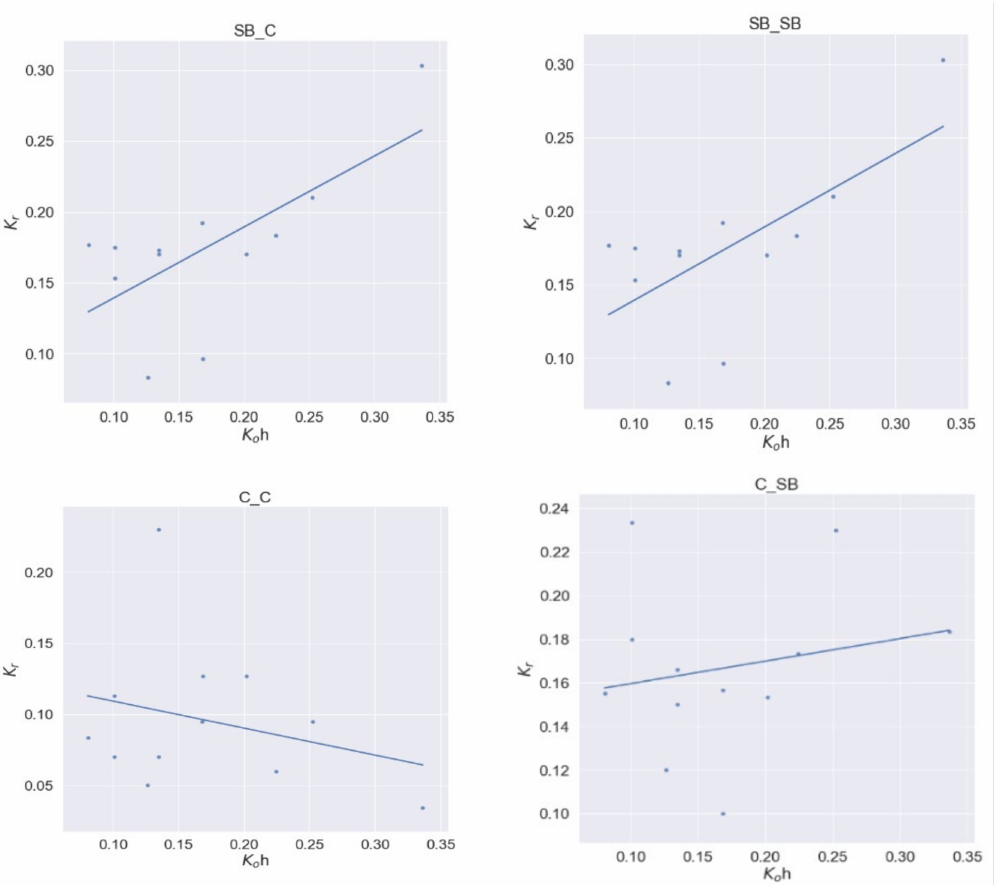
Figure 15. Wave reflection as compared to K o h